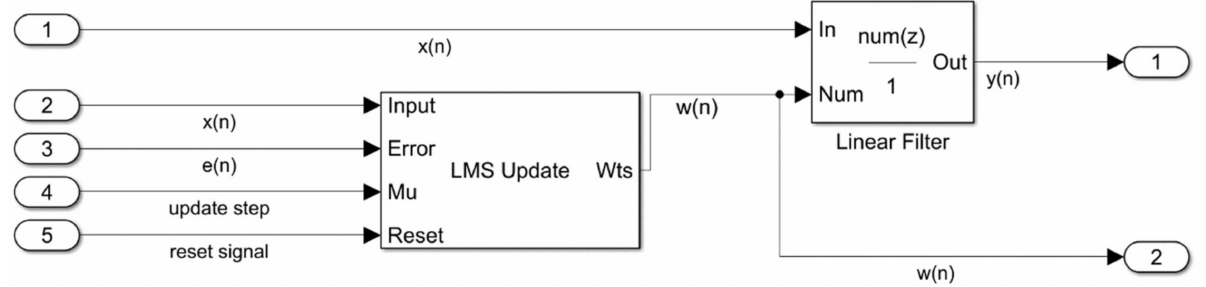
Figure 10. Scheme of the Simulink control algorithm